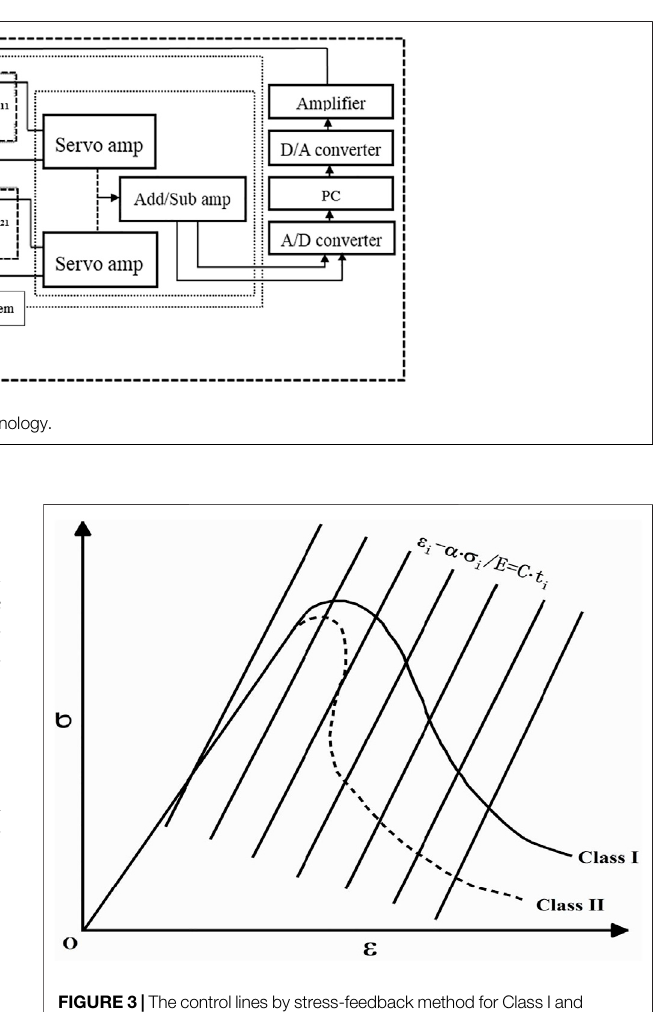
FIGURE 3 | The control lines by stress-feedback method for Class I and Class II